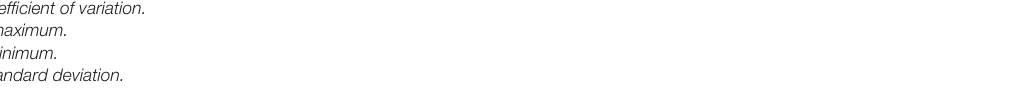
TABLE 3 | Genetic and phenotypic correlations between adjusted means for coleoptile length and deep-sowing seedling emergence in individual and combined trials for the DP population phenotyped from 2015 to 2019.